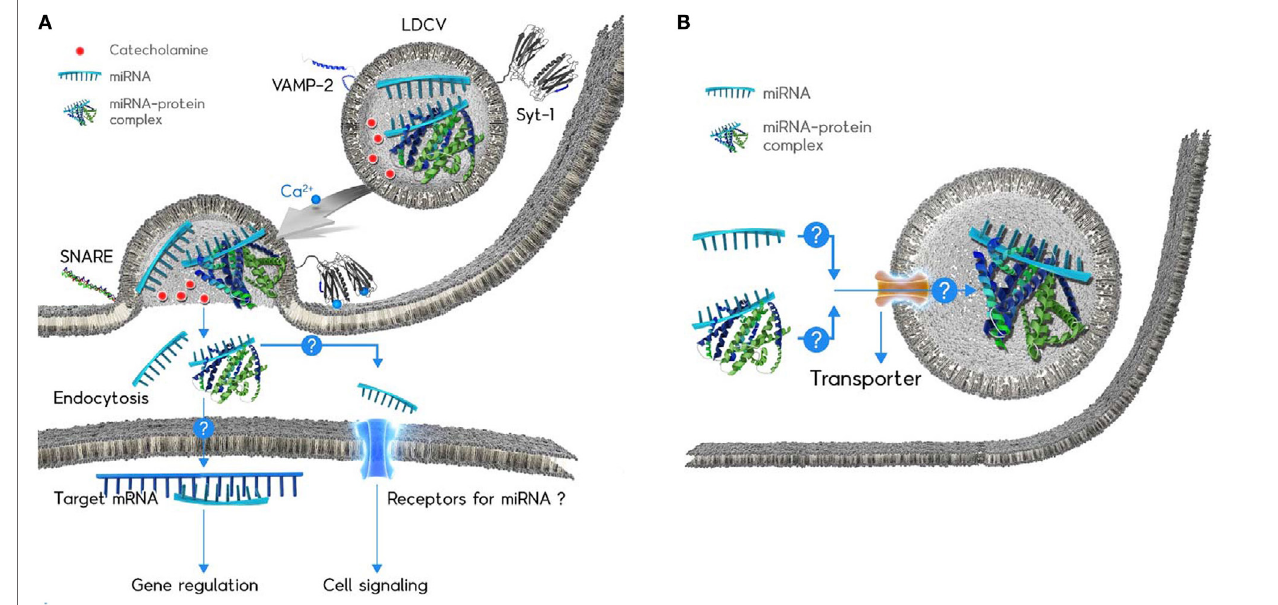
FiGURe 1 | Schematic diagram of the microRNAs (miRNA) exocytosis mechanisms (A) and the working hypothesis of the miRNA loading into large dense-core vesicles (LDCVs) (B) . (A) Catecholamines (red ball) are typical neurotransmitters stored in LDCVs. LDCVs also contain a variety of miRNAs including miR-375. The assembly of neuronal SNAREs including VAMP-2, SNAP-25A, and syntaxin-1A mediates miRNA exocytosis from chromaffin cells, neuroendocrine cells. Synaptotagmin-1 (Syt-1) is considered as a Ca 2 + (green ball) sensor to trigger miRNA exocytosis. The membrane insertion of Ca 2 + -bound Syt-1 results in the fusion pore formation. Ribomone hypothesis: miRNAs stored in vesicles together with classical neurotransmitters are released by vesicle fusion, thereby contributing to cell-to-cell communication (24). Two hypothetical functions of released extracellular miRNAs; (i) miRNAs might be taken up by endocytosis into target cells where miRNAs regulate gene expression. (ii) miRNAs might be able to stimulate receptors or ion channels as ligands, thereby leading to cellular signalling. Adapted from Gümürdü et al. (24). (B) The mechanisms by which miRNA or miRNA–protein complex can be loaded into LDCVs remain elusive. Structure of miRNA-binding protein is artificial for the